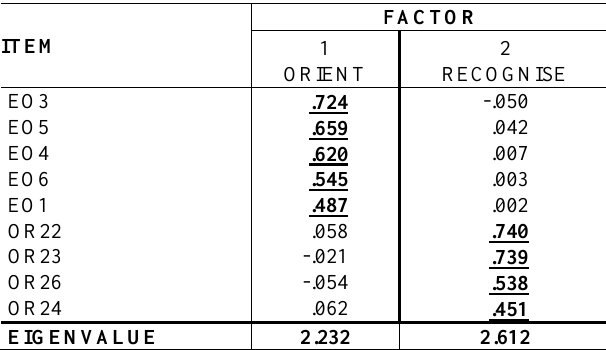
Table 2: Rotated factor loadings: Intervening variables